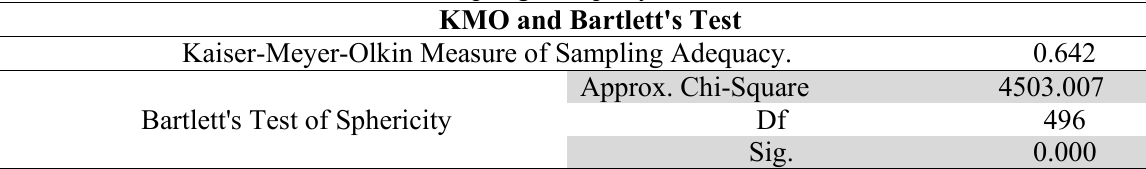
KMO and Bartlett’s Test Measure of Sampling Adequacy as a whole KMO and Bartlett's Test Kaiser-Meyer-Olkin Measure of Sampling